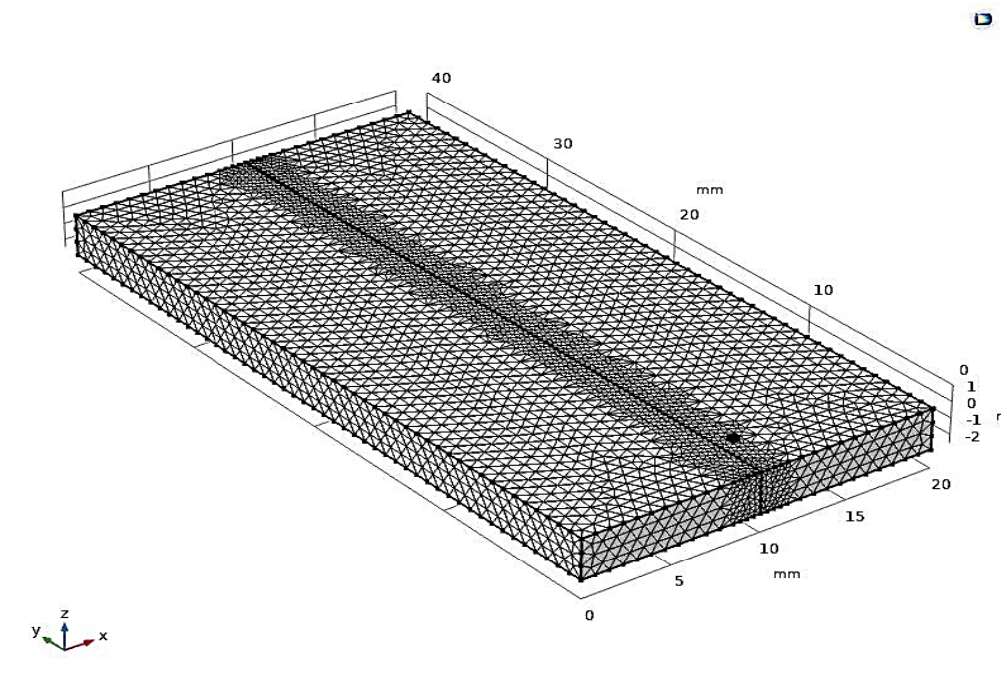
Figure 4. Mesh modeling of the weld joint assembly.